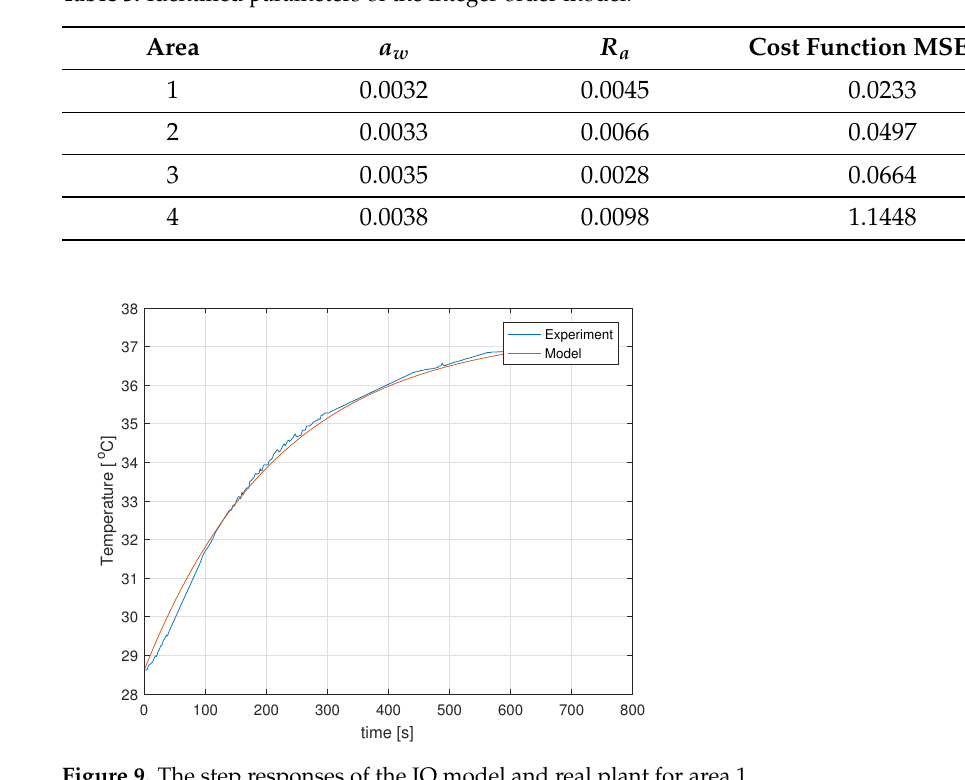
Figure 9. The step responses of the IO model and real plant for area